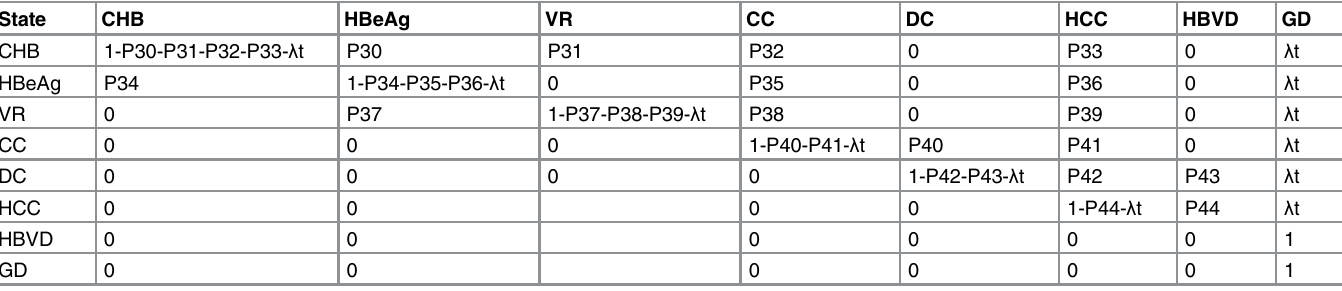
Table 1. Transition matrix of each state of chronic hepatitis